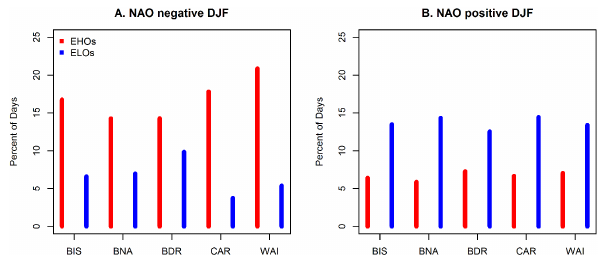
Figure 7. Average fraction of days (in %) identified as EHO and ELO during (a) negative and (b) positive NAO phases in the winter (DJF)